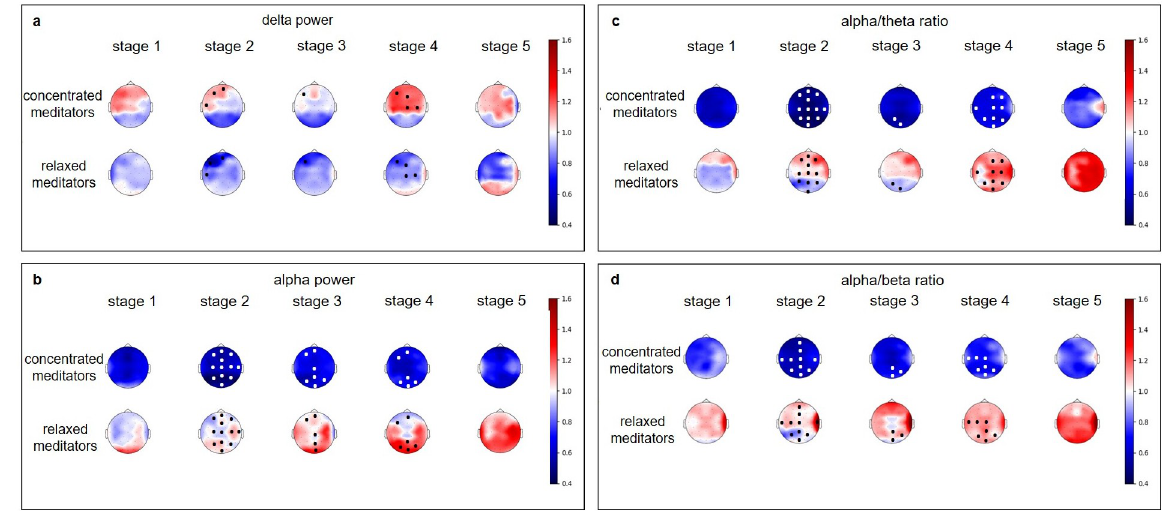
Fig 8. Changes of EEG-derived indices in the “relaxed” and “concentrated” experienced meditators. All values were normalized to the individual baseline. Data are presented as a group median value. We have used a common colorbar for all EEG indices and groups to make it easier to compare effects. Dots mark significant (p < 0.05) difference between two groups according to the one-way ANOVA test, followed by the post hoc Tuckey’s test. The colors of the dots were chosen to improve visibility and don’t carry any additional information.